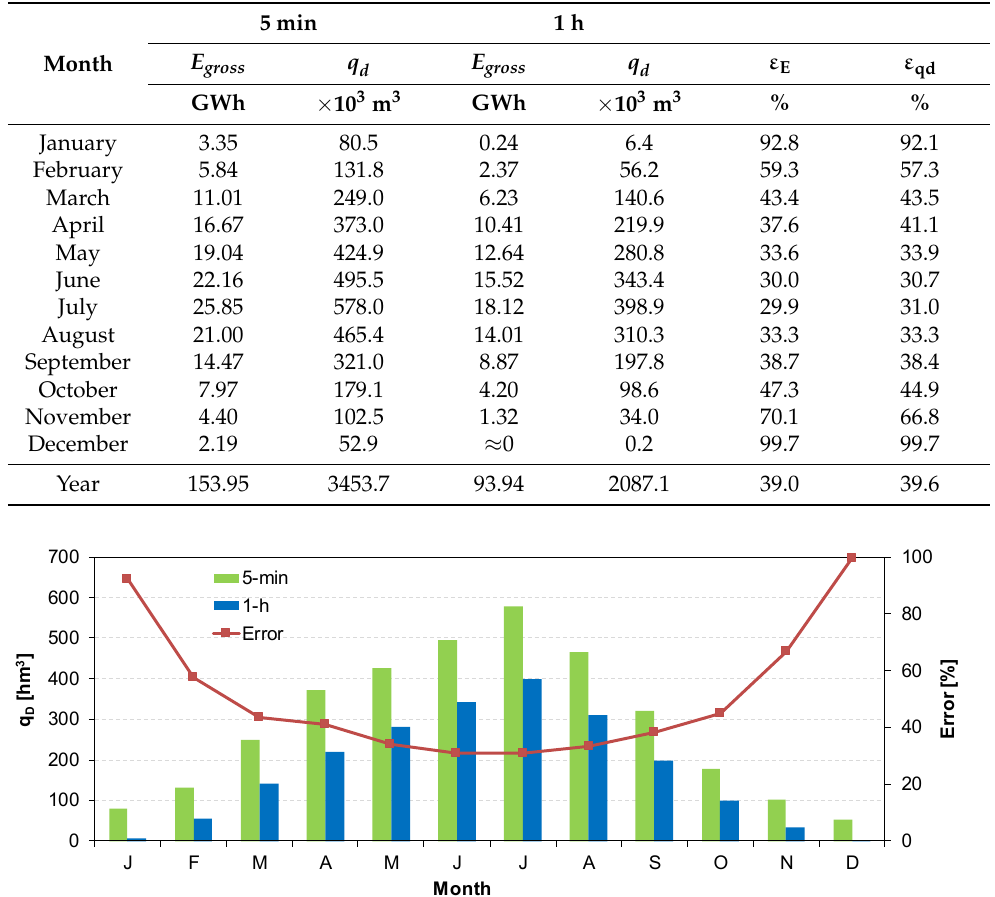
Table 2. Monthly electric gross energy ( E gross ) and freshwater production ( q d ) as a function of the time step during a year of operation. ε E and ε qd are the relative errors of E gross and q d , respectively.